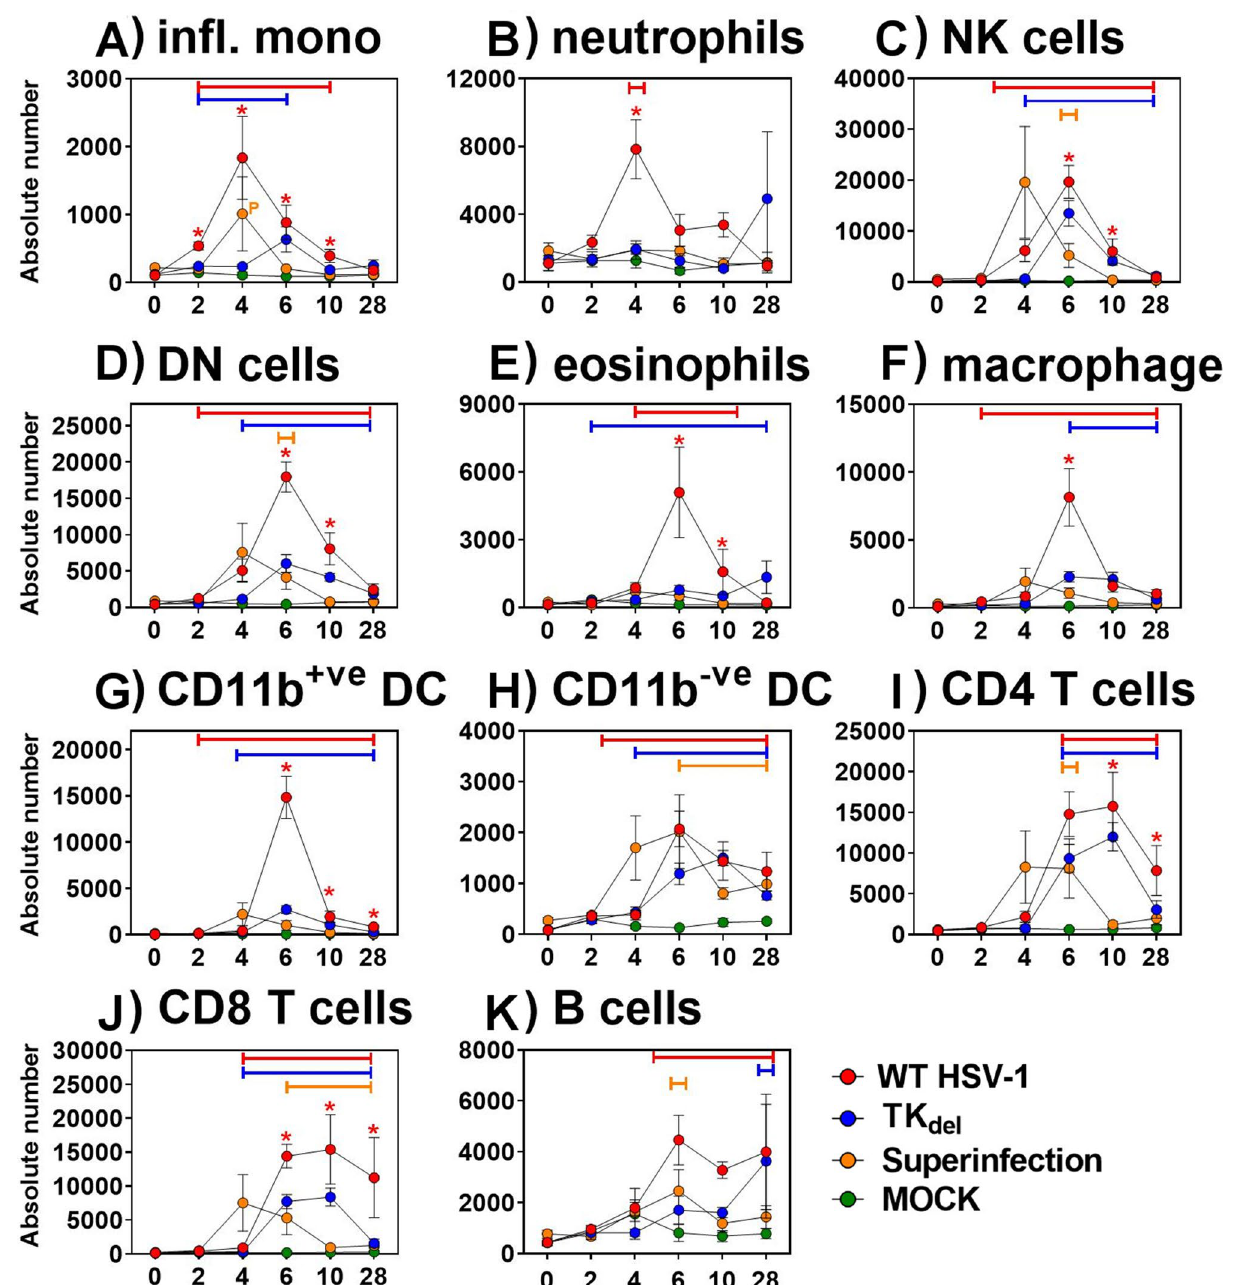
Figure 2. Immune subsets in the iTG. Naïve mice were infected in the lip with WT HSV-1, PBS (mock; green line), or with TK del . Mice of the superinfection model received an initial inoculation of TK del in the right lip on day -4, and were challenged with WT HSV-1 on day 0 in the left lip. On different days for each group, immune subsets ( A – K ) were defined and absolute numbers quantified by flow cytometry in iTG single cell suspensions. Colored bars indicate significant differences from uninfected tissue at day 0. Red asterisks identify when WT HSV-1 compared to PBS mock infection (green) and superinfection model was significantly different ( p < 0.03; permutation test ). Colored P indicates significance between Mock and the color-corresponding group. Each point represents n = 4 individual biological replicates. Figures were formulated using Flowjo, Excel and